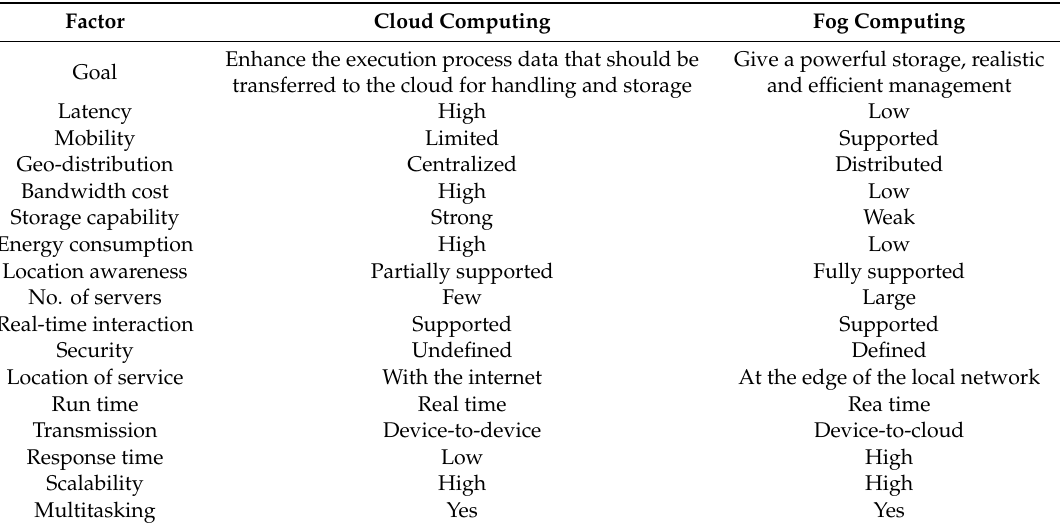
Figure 3. Fog computing in remote monitoring system. Table 1. Difference between cloud computing and fog computing.